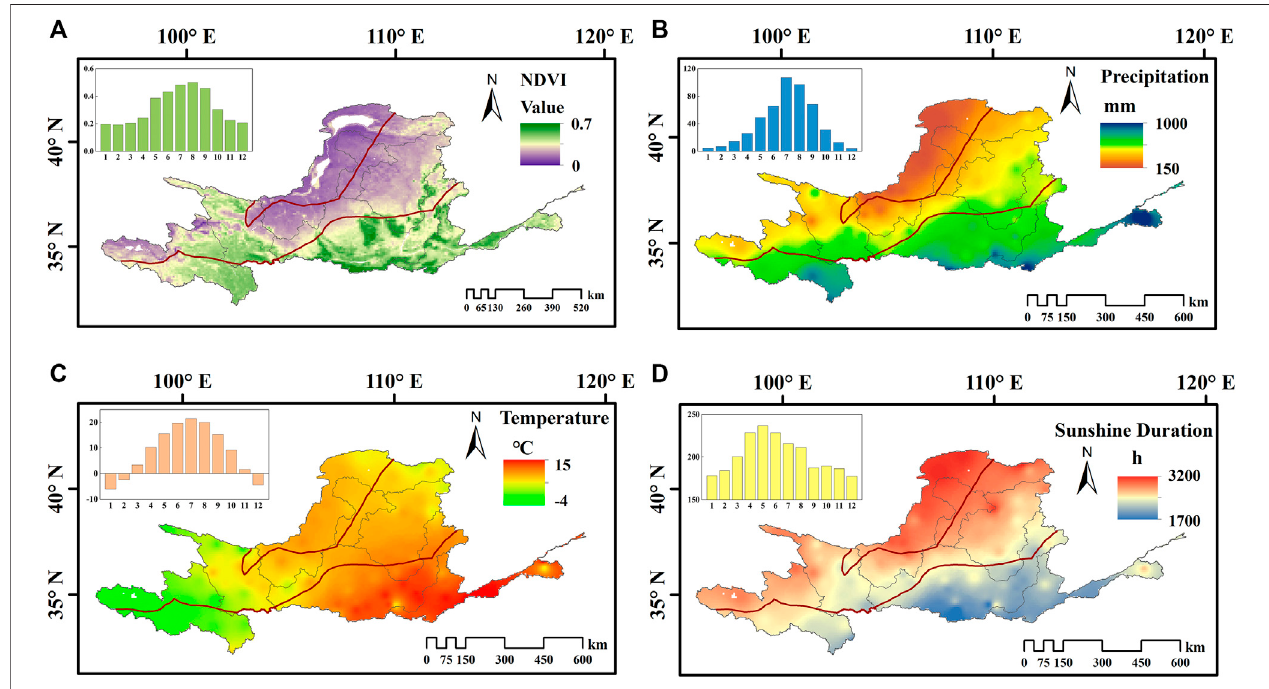
FIGURE3| Spatial patternsofannual average (A) NDVI, (B) precipitation, (C) temperature,and (D) sunshinedurationduring 1982 – 2015intheYellow RiverBasin.